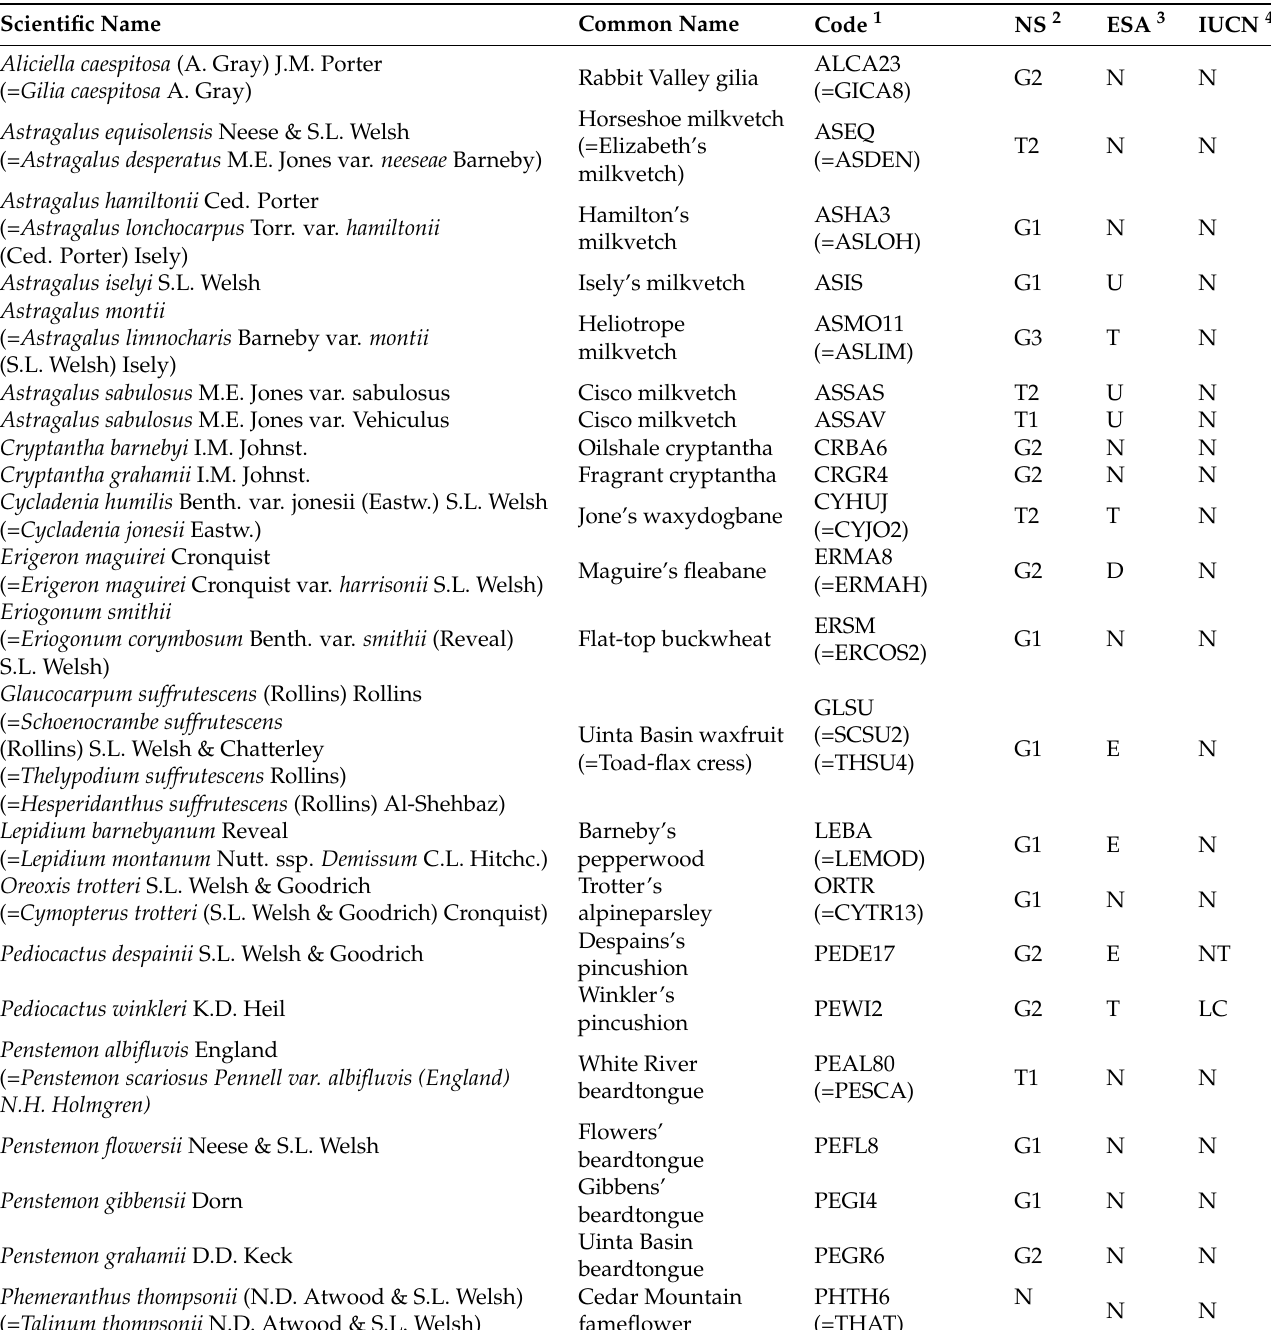
Table 1. Scientific and common name, code, and associated communities of the 29 flowering plant species of interest. Table is organized first by associated community then alphabetical or- der on scientific name. (=scientific name) and (=code) represent the alternative names and codes of synonymous